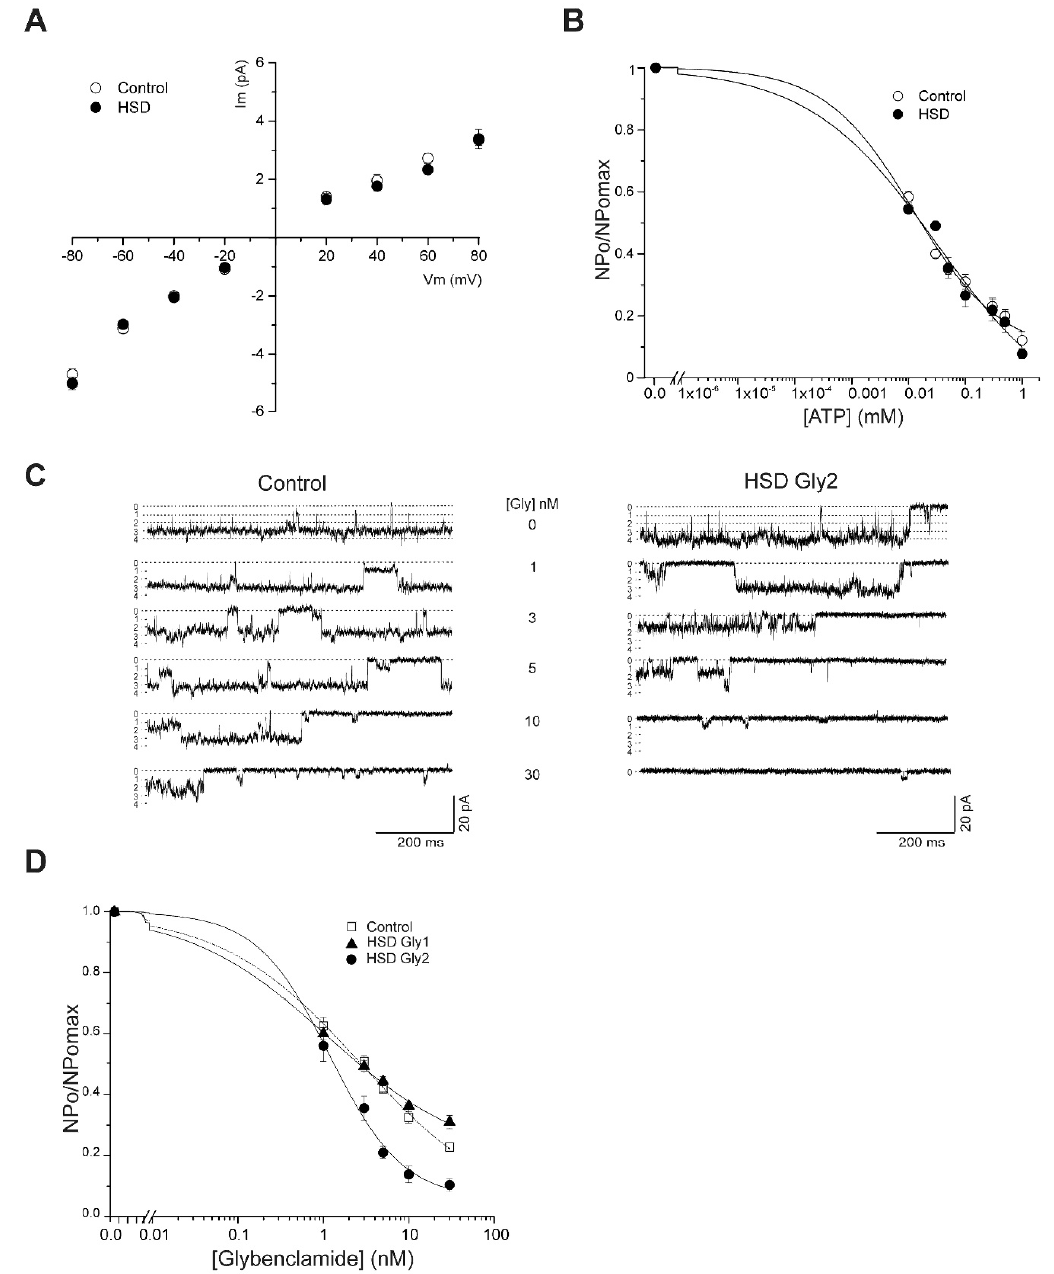
Figure 4. Early effects of MS on ATP and Glybenclamide sensitivity of K ATP channels in beta cells. ( A ) Current to voltage relationship for single channels. Data represent the mean ± SE. The unitary conductance was 56 ± 2 and 59 ± 4 pS for control ( n = 10) and HSD ( n = 11), respectively. ( B ) ATP sensitivity of K ATP channels from control and HSD groups. The data were fitted to the Hill equation. IC50 and Hill coefficient were 17.4 ± 0.04 and 0.5 ± 0.04 for control group ( n = 10), and 18.1 ± 0.001 µM and 0.50 ± 0.07 for the HSD group ( n = 7), respectively. Data represent the mean ± SE. ( C ) Glyben- clamide blocked of K ATP channels activity in a concentration-dependent manner (1, 3, 5, 10 and 30 nM), applied to the cytoplasmic face of an inside-out membrane patches from control and HSD Gly2 (Vm = − 60 mV). Different currents levels are indicated to the left of the traces. ( D ) Concentration-